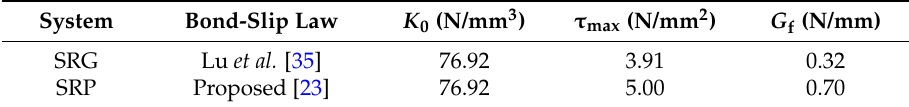
Table 4. Input parameters of the cohesive surface (modes II and III).